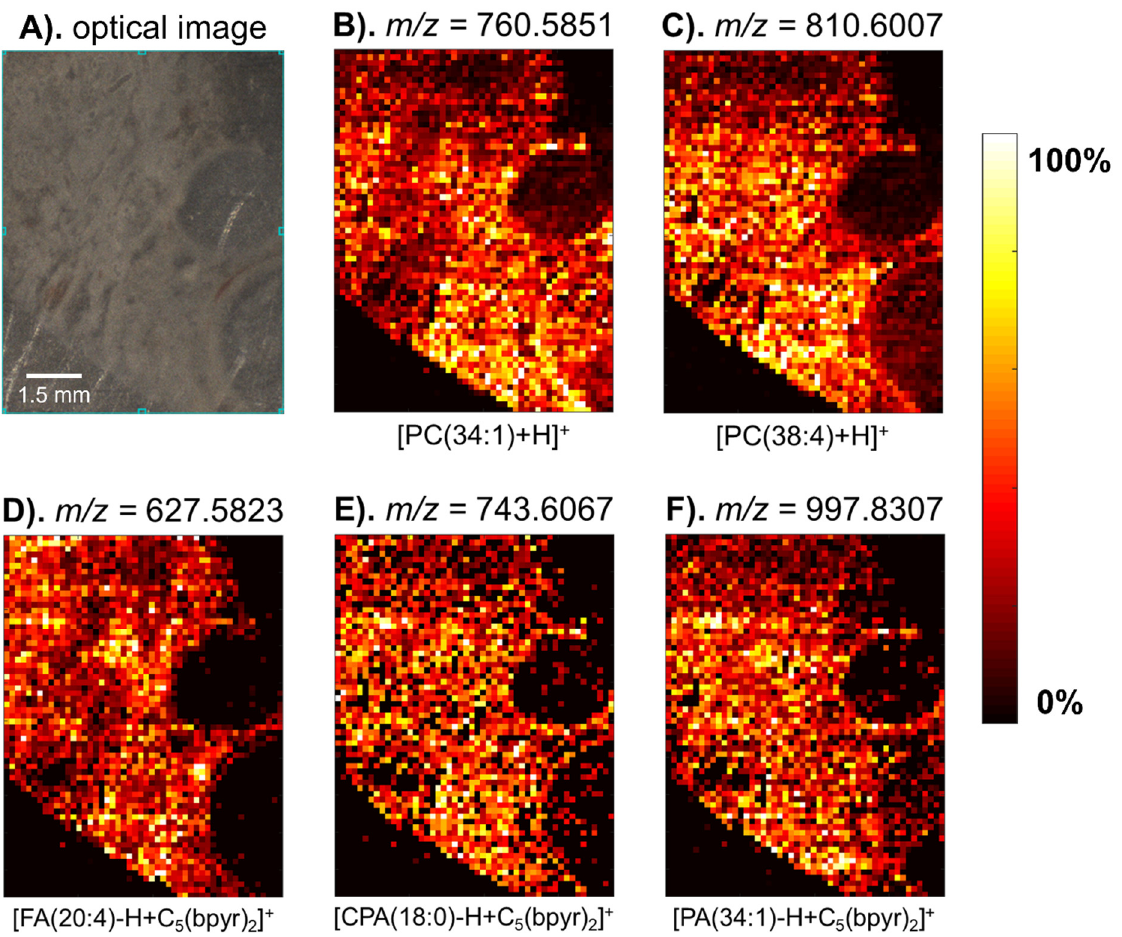
Figure 5. Heatmap images of metabolites detected from the hen ovary section in [C 5 (bpyr) 2 ] 2+ adducted positive ionization polarity with their putative identifications labeled at the bottom. ( A ). Optical image of the hen ovary section before MS analysis. ( B , C ). Heatmaps of representative protonated metabolites. ( D – F ). Heatmaps of representative deprotonated metabolites adducted with [C 5 (bpyr) 2 ] 2+ .